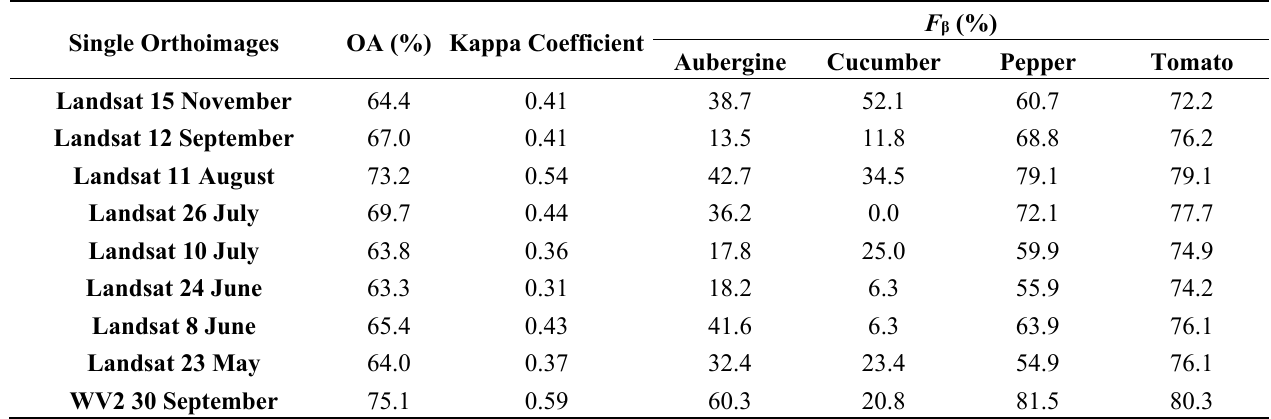
Table 6. Accuracy indices from single orthoimages using the no GLCM strategy. Single